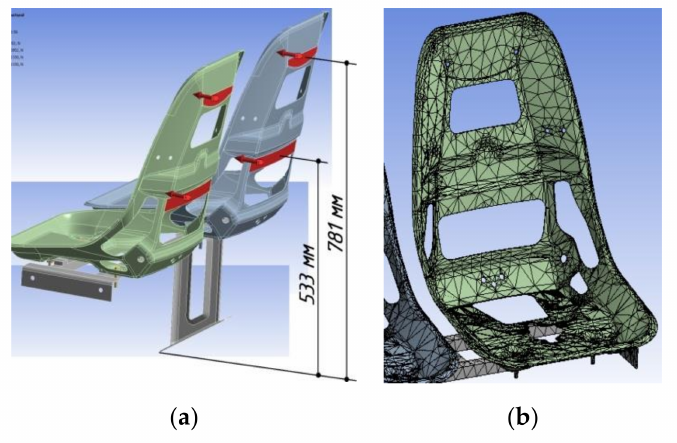
Figure 5. Seat model made of pressed sheet: ( a ) solid model; ( b ) Finite Element Method (FEM)